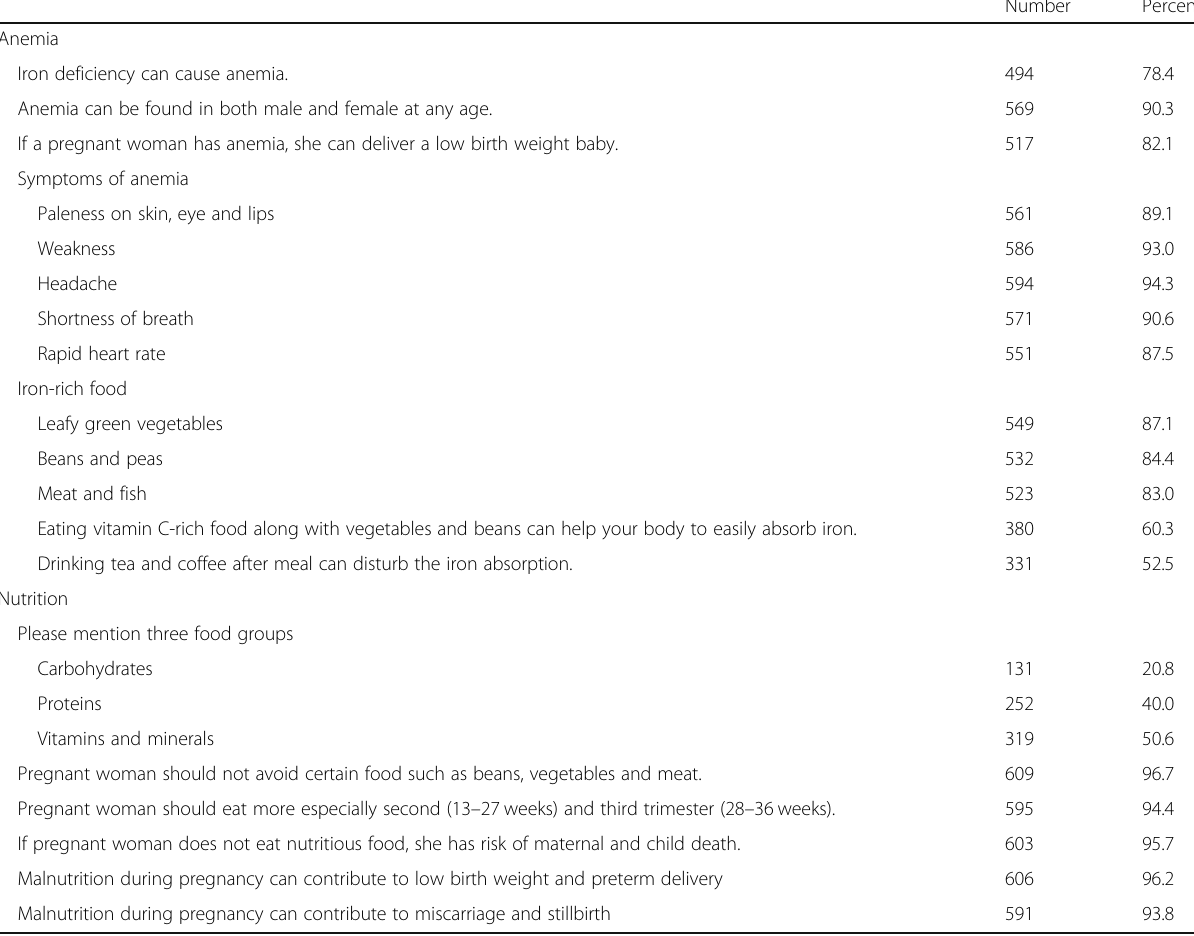
Table 3 Accuracy rate of response to each knowledge question (Continued)